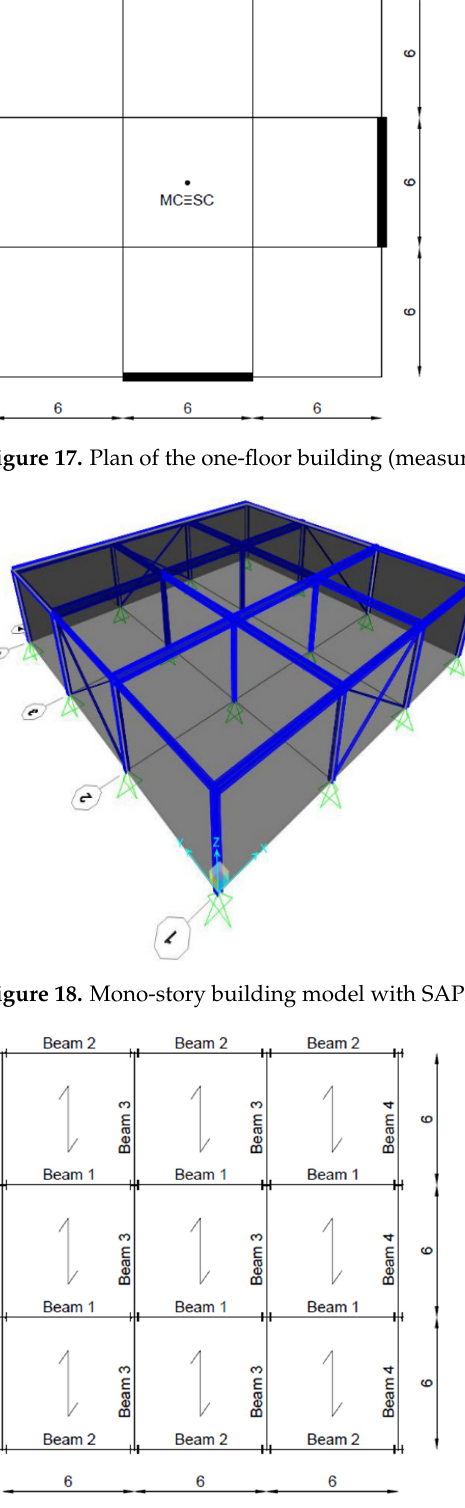
Figure 19. Warping of the floors and numbering of the beams (valid for all case studies; measurements in m).